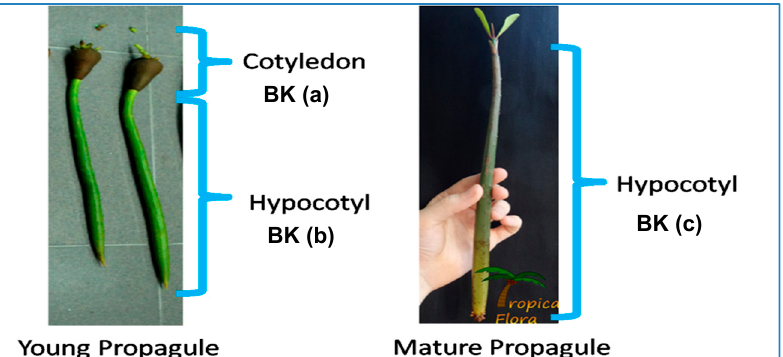
Figure 1. Plant parts of young and mature propagules of R. mucronata : ( a ) cotyledon, ( b ) young hypocotyl, ( c ) mature hypocotyl